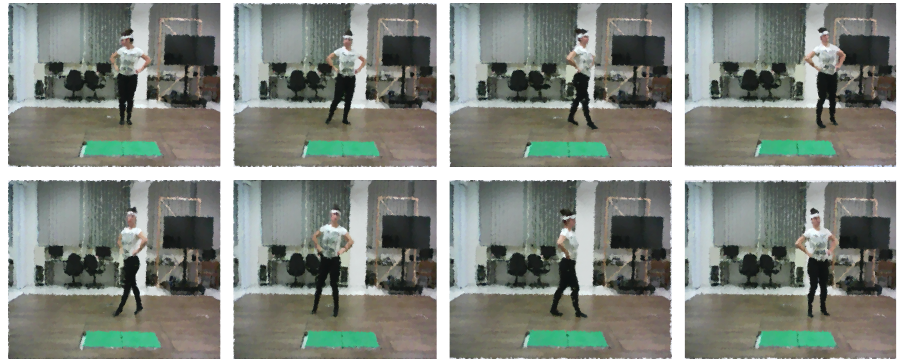
Figure 10. Illustration of Enteka dance performed by dancer 3.